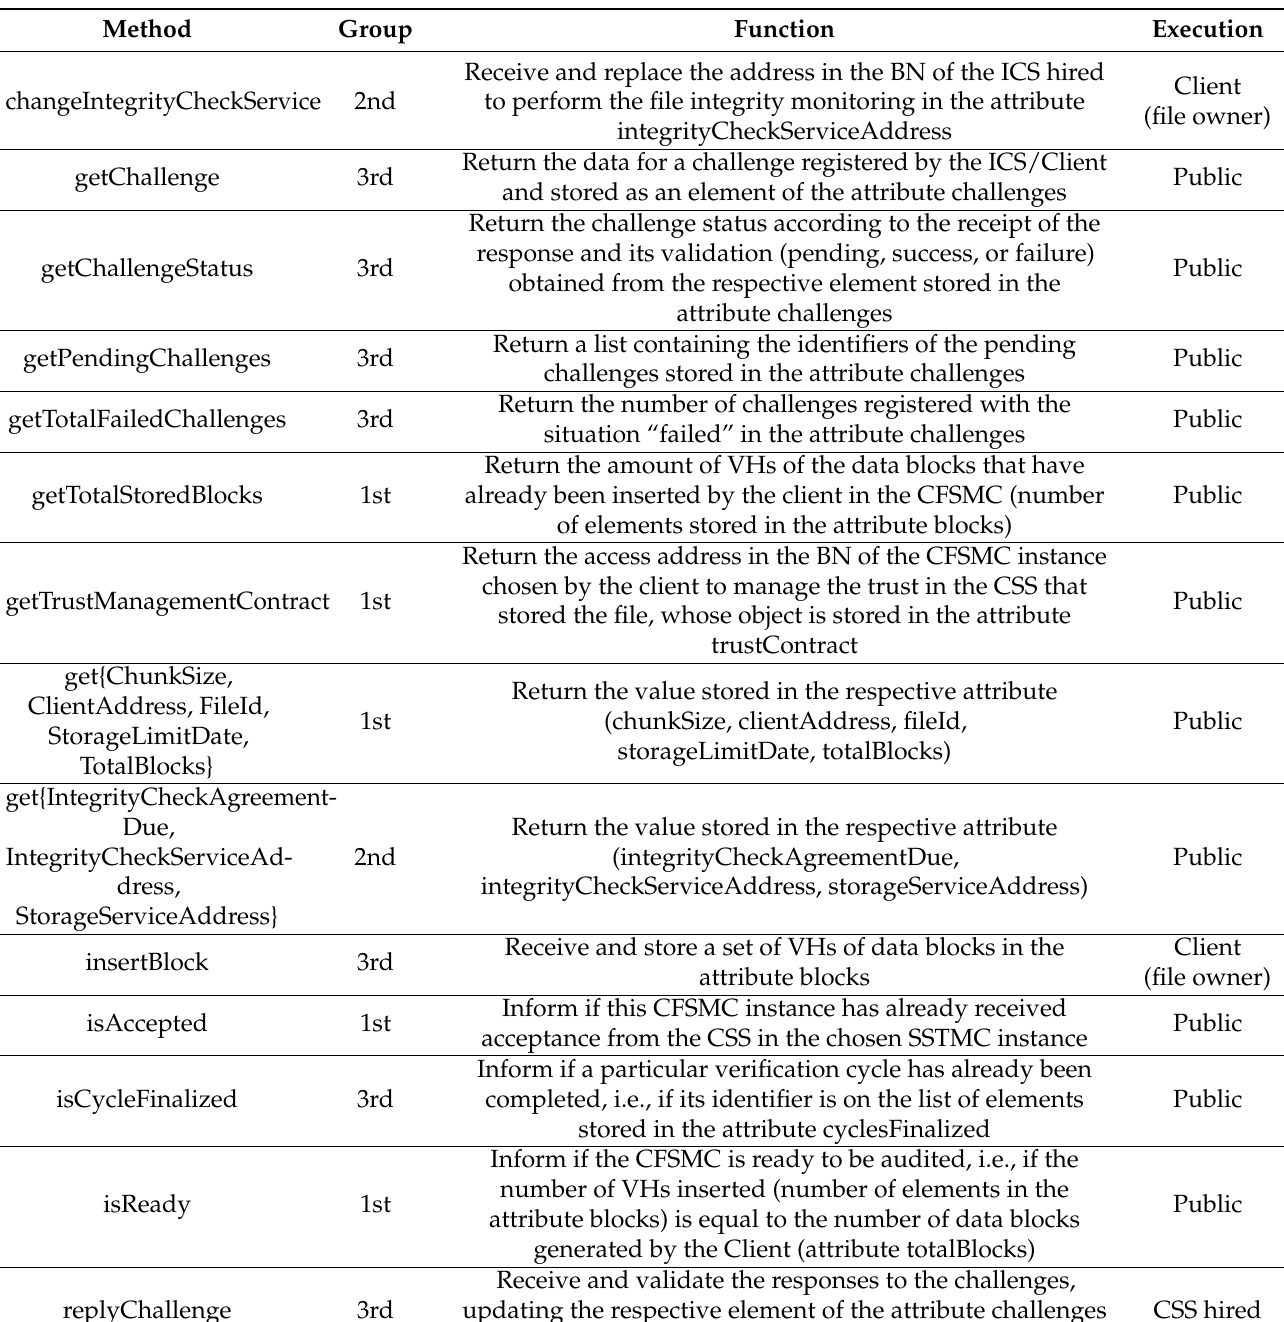
Table 4. Functions of CFSMC methods and the roles that can perform